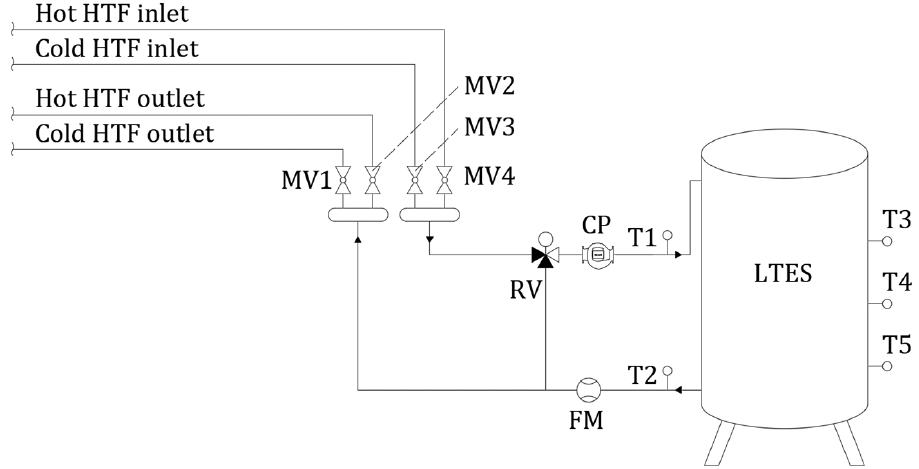
Figure 7. Schematic representation of an experimental test system segment with LTES tank, HTF flow rate and inlet temperature regulation, cold HTF inlet, cold HTF outlet, hot HTF inlet, and hot HTF outlet.